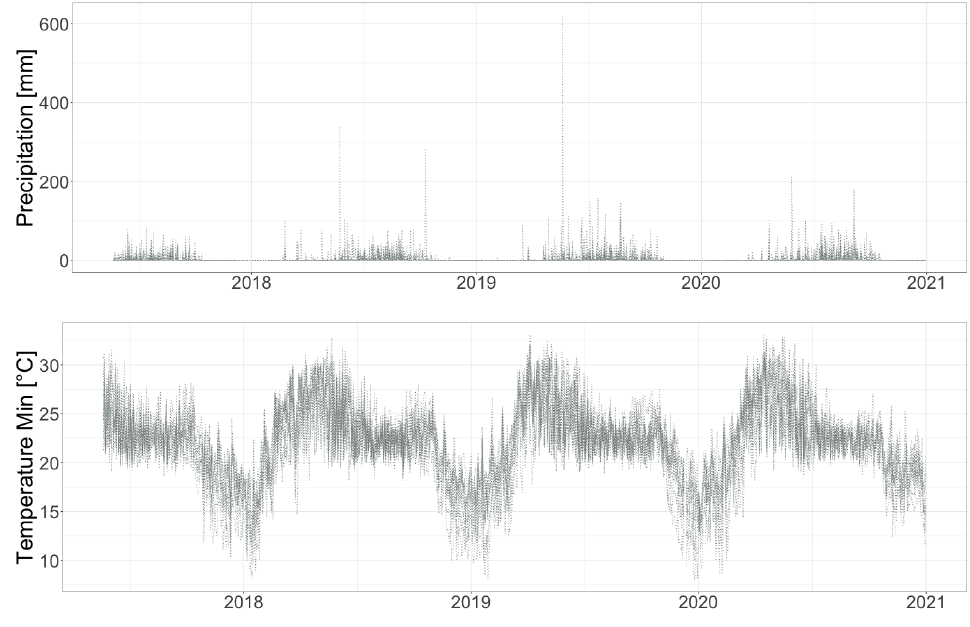
Figure 4. Daily precipitation and minimum temperature time series of all TAHMO stations in Burkina Faso to perform plausibility checks.